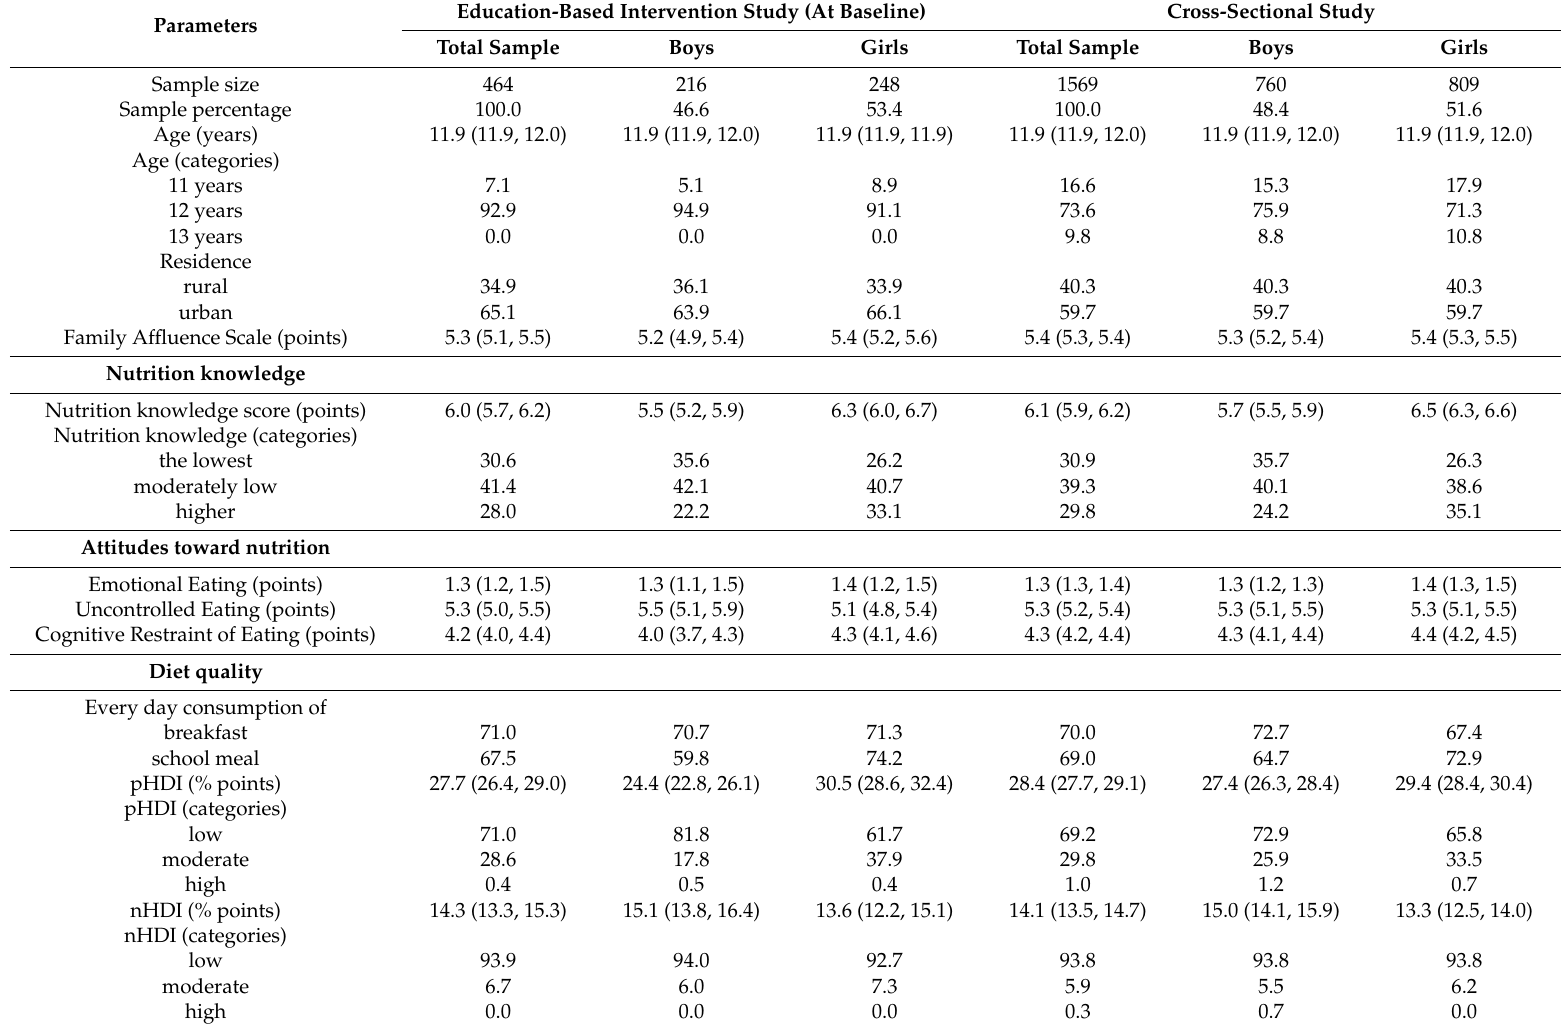
Table 7. Sample characteristics by study design (% or means (95% confidence